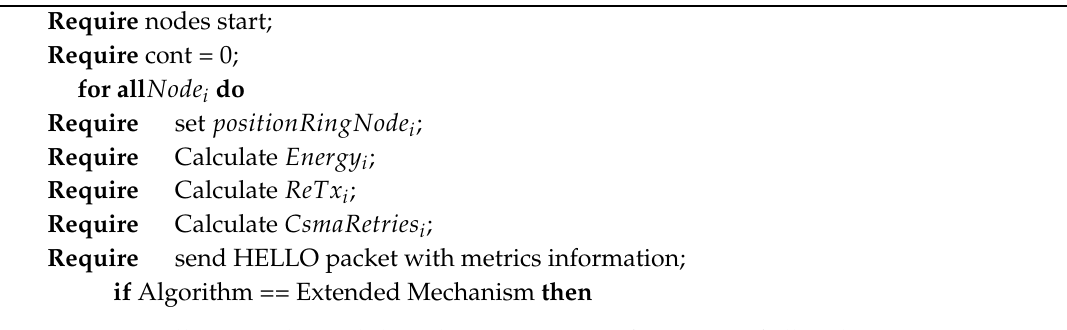
Algorithm 1: Collaborative detection